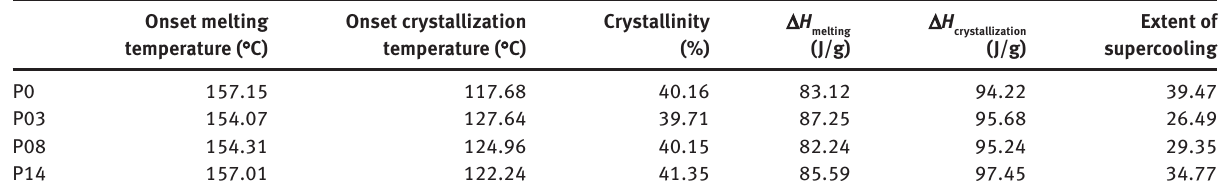
Table 2: Calorimetric data of the polypropylene filaments. Onset melting